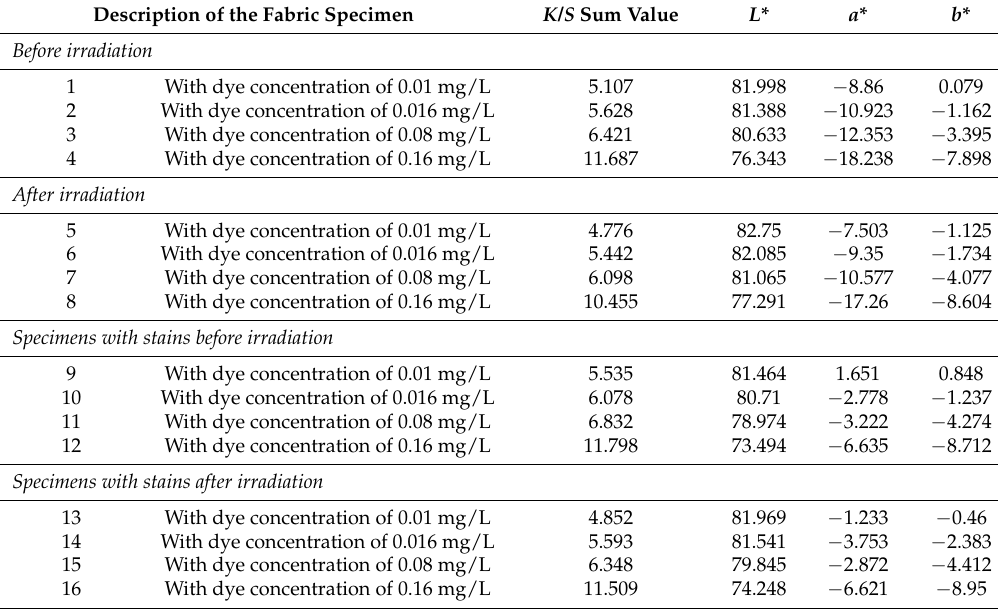
Table 3. K / S sum values and CIE color coordinates values of the test samples.